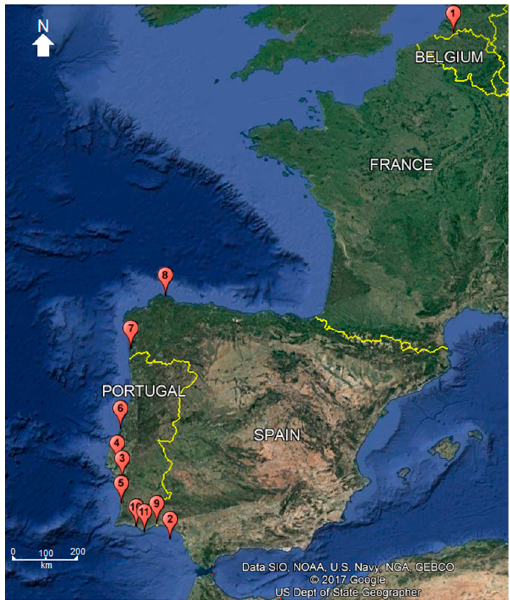
Figure 1. Locations where weakfish Cynoscion regalis (Bloch & Schneider, 1801) (Actinopterygii: